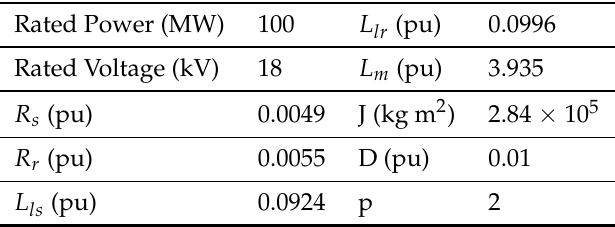
Table A2. DFIG model